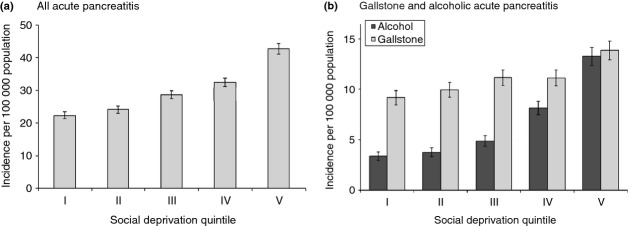
Incidence of acute pancreatitis (per 100 000 population) according to social deprivation quintile (I = most affluent, V = most deprived) in Wales from 1999 to 2010 for (a) All acute pancreatitis. (b) Gallstone and alcoholic acute pancreatitis. Incidence is standardised for age group and gender. Vertical bars represent 95% confidence intervals.